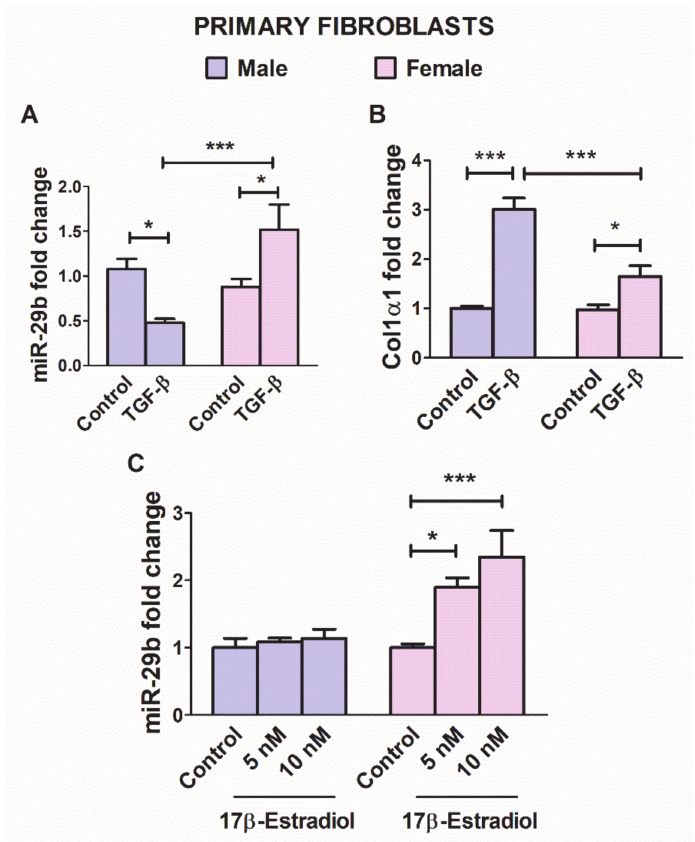
Figure 2. Relative expression changes in miR-29b ( A ) and Col1 α 1 ( B ) in cultured cardiac fibroblasts isolated from male and female myocardium, stimulated with TGF- β 1 (10 ng / mL) for 24 h in serum-free medium. Relative changes in the expression of miR-29b in cardiac fibroblasts from male and female mice stimulated with 17 β -estradiol (5 and 10 nM) for 24 h ( C ). Data are reported as mean ± SEM * p < 0.05, *** p < 0.001 (two way ANOVA and Bonferroni’s post-hoc